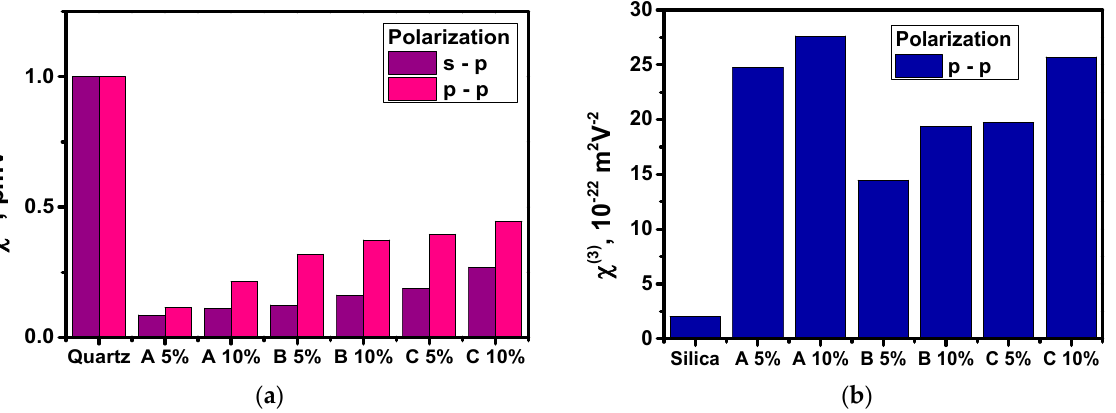
Figure 13. Second- ( a ) and third-order ( b ) NLO susceptibilities calculated for studied A/PVK, B/PVK, and C/PVK thin films with different content of chromophores, taking into account experimentally obtained data.